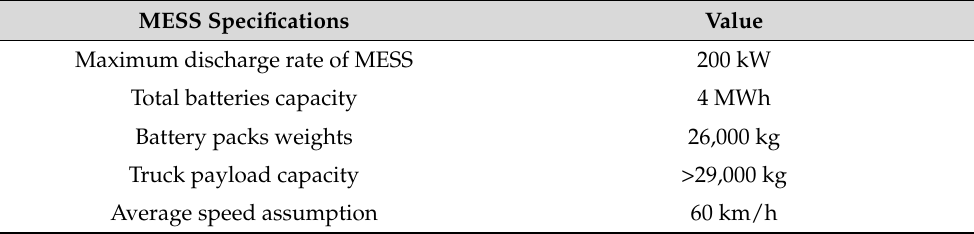
Table 3. Summary of simulation results.